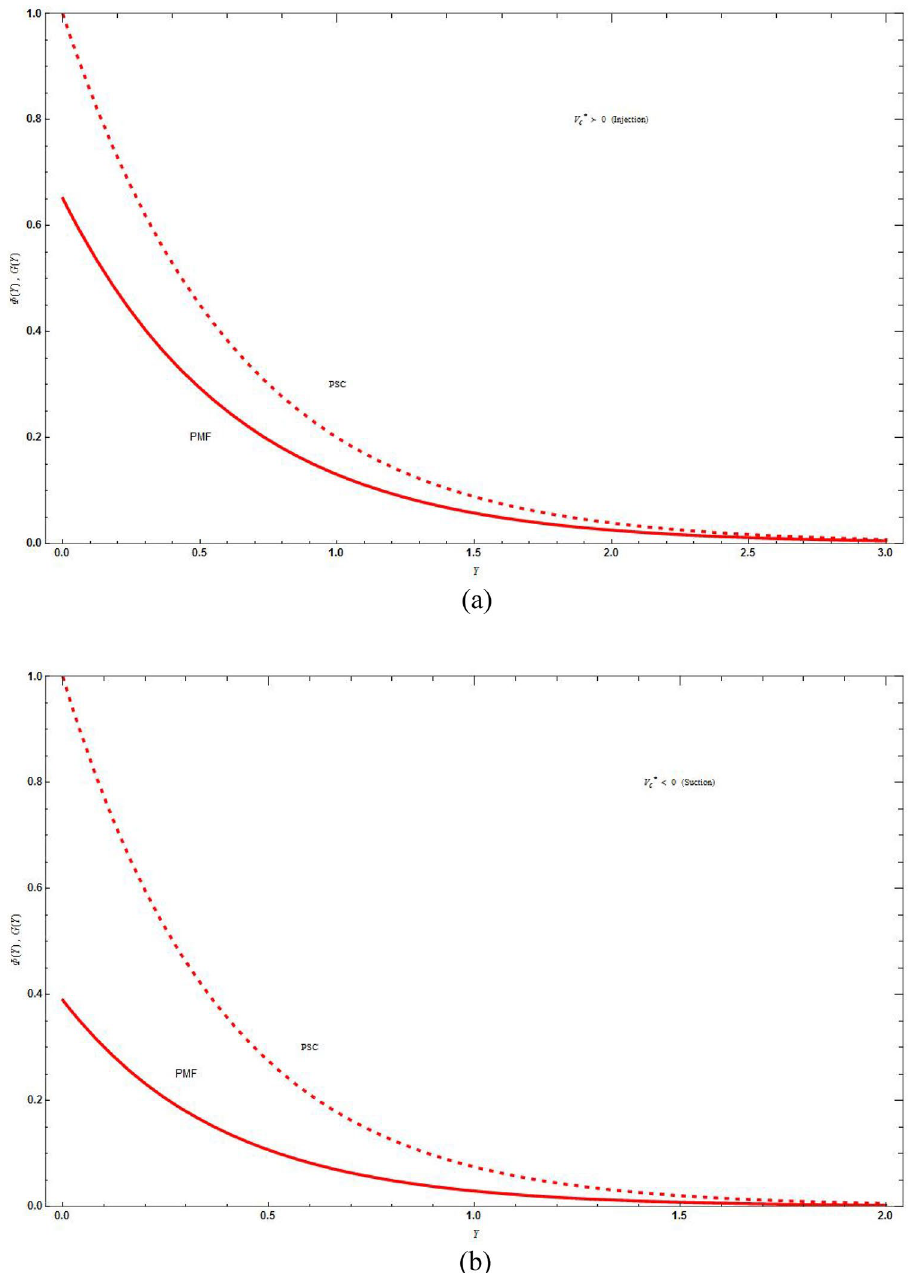
Figure 5. The concentration distribution plot shows the difference between curves of PSC and PMF keeping the parameters as M and in ( b ) for suction the hybrid nanofluid Cu